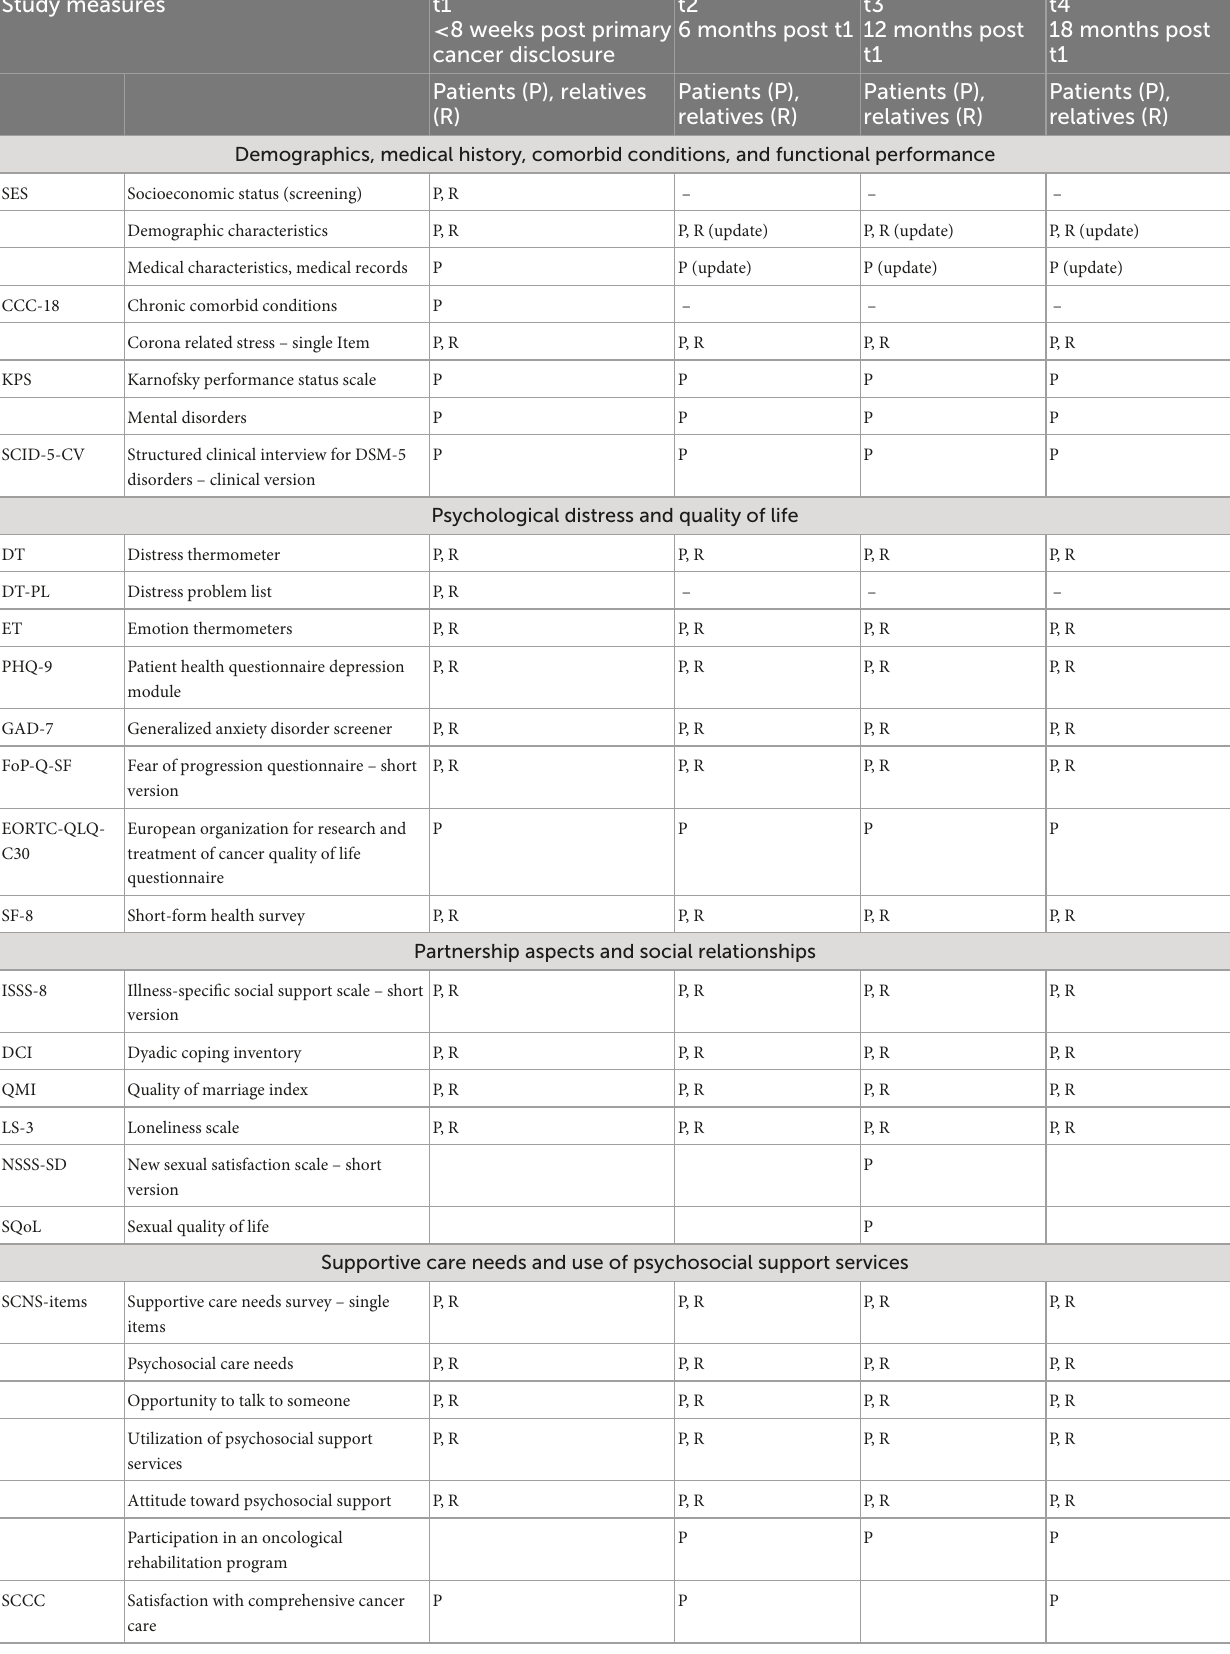
Assessment schedule and